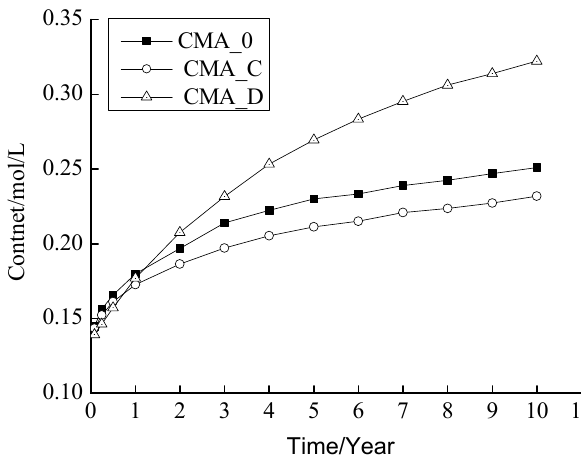
Figure 12. Concentration of chloride in 5 cm.